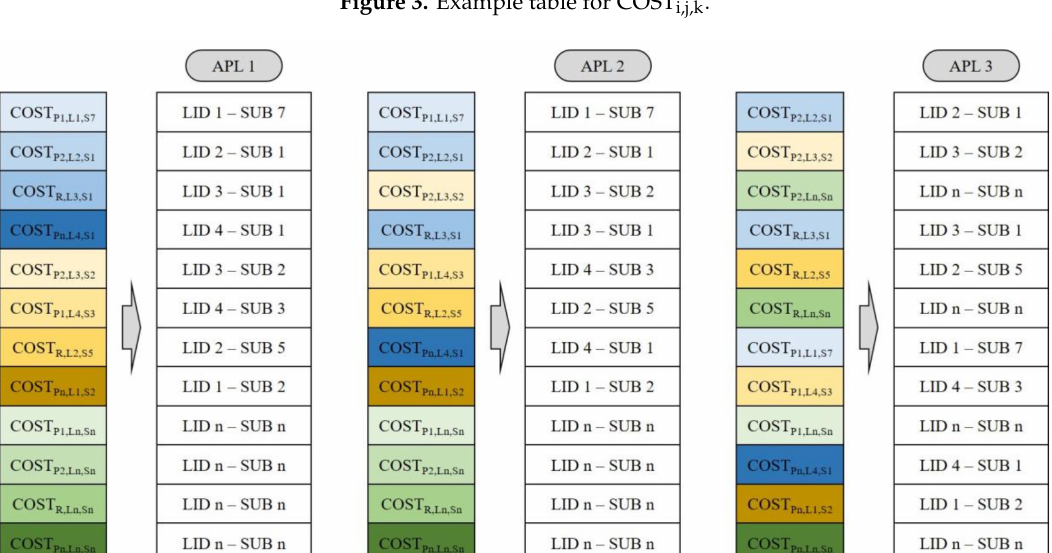
Figure 3. Example table for COST i,j,k .